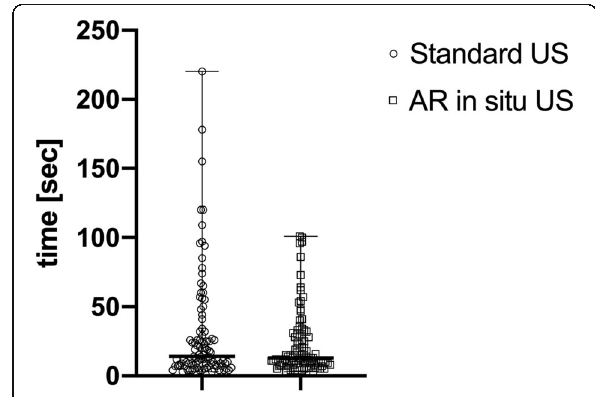
Fig. 4 Differences of time to target puncture of all operators using the standard ultrasound versus augmented reality in situ ultrasound